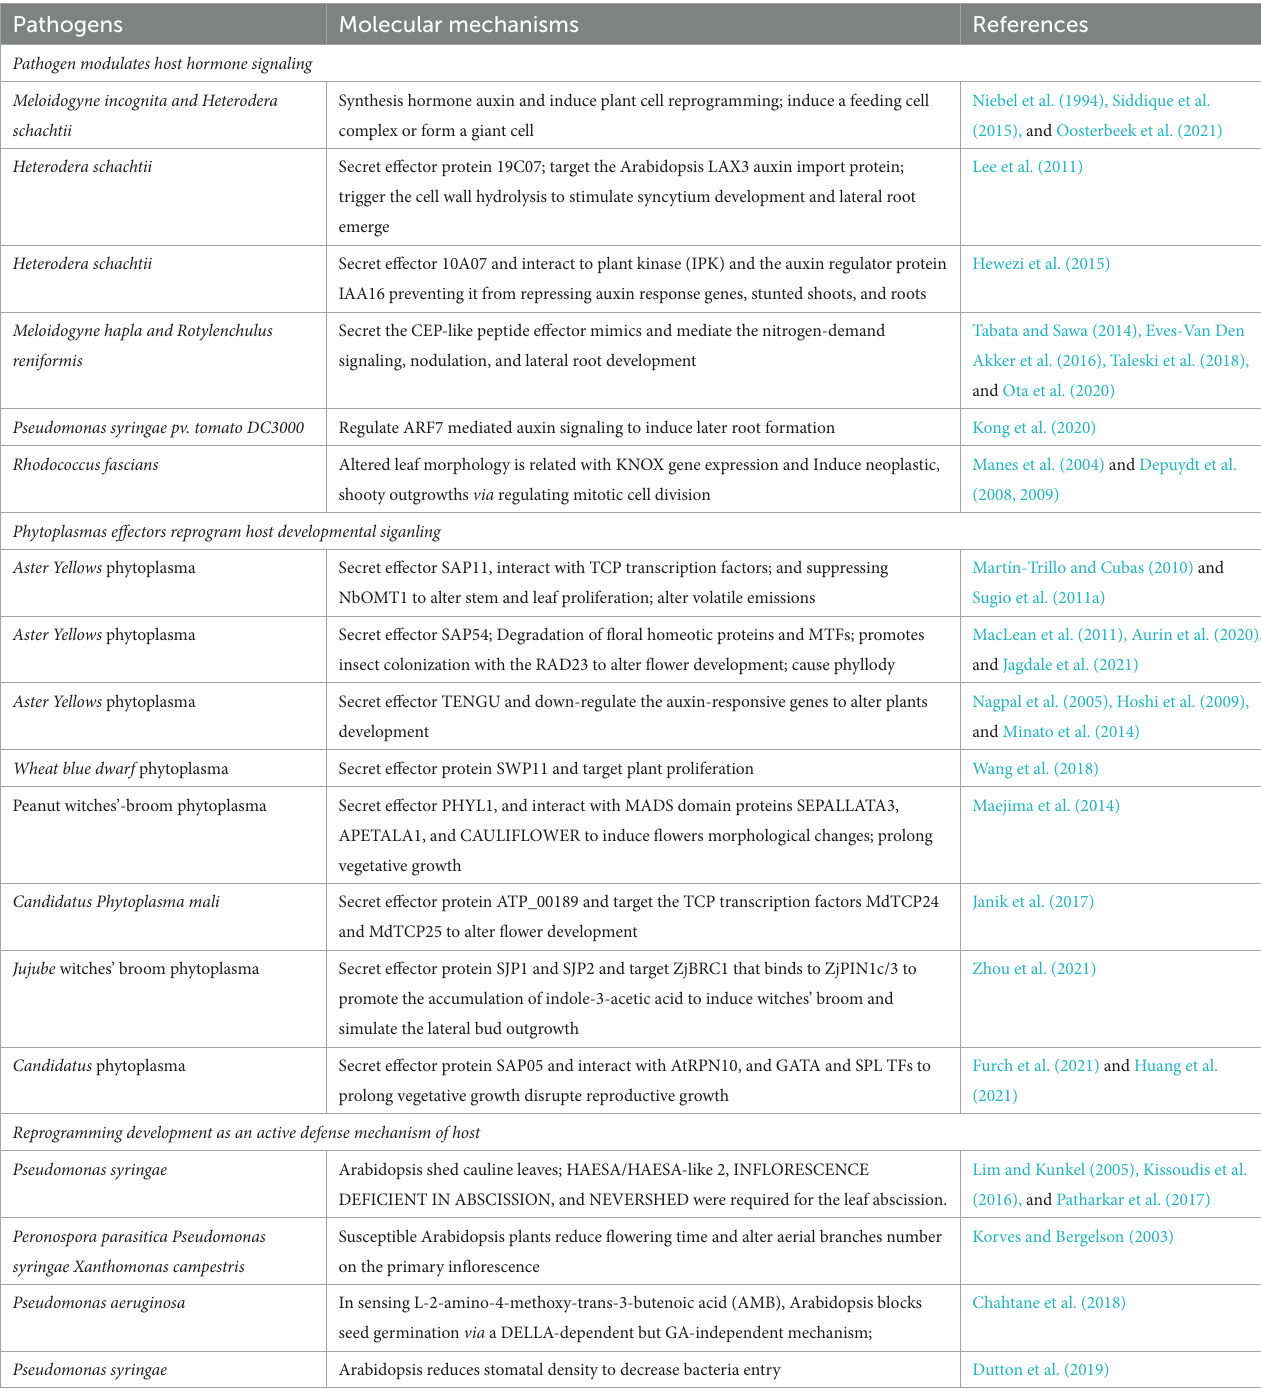
TABLE 1 Examples of pathogen-induced changes in plant growth and development with known molecular